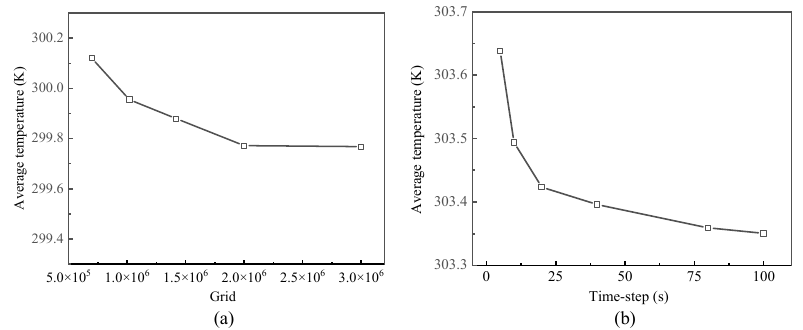
Figure 4. ( a ) Grid independence validation; ( b ) time ‐ step independence validation.